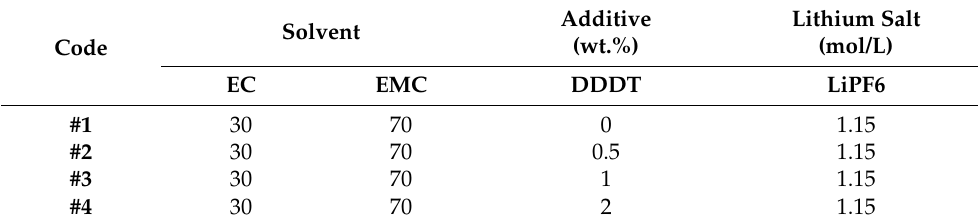
Figure 1. The chemical structure of dihydro-1,3,2-dioxathiolo[1,3,2]dioxathiole 2,2,5,5-tetraoxide (DDDT). Table 1. Compositions of electrolytes #1–#4.